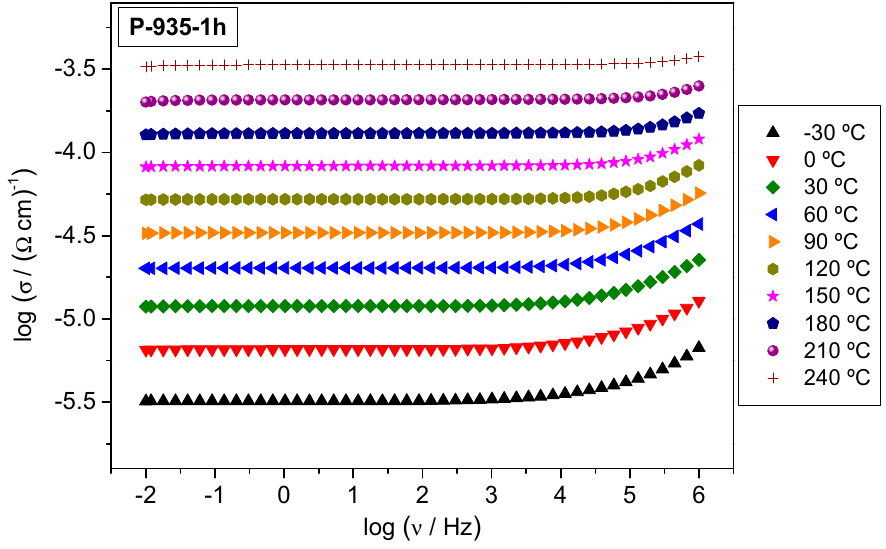
Figure 4. Conductivity spectra at different temperatures of glass-ceramics prepared at 935 ° C for 1 h. For all samples, the DC conductivity exhibits Arrhenius temperature dependence and hence has characteristic activation energy, see Figure 5a. The activation energy for DC conductivity, E DC , for each sample was determined from the slope of log( σ DC T ) vs. 1000 / T using the equation σ = σ / k σ σ − E DC T 0 exp( DC B T ), where DC is the conductivity, 0 is the pre-exponential factor, E DC is the activation energy, k B is the Boltzmann constant, and T is the temperature (K). The DC conductivity ◦ at 30 C and determined activation energy, E DC , for the parent glass and all glass-ceramics are displayed in Table 2.